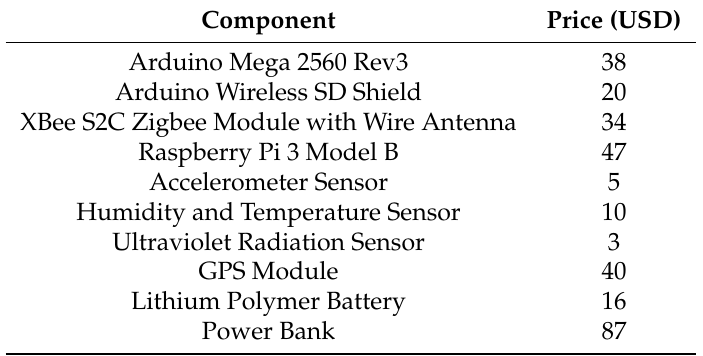
Table 3. Cost of each of the utilized